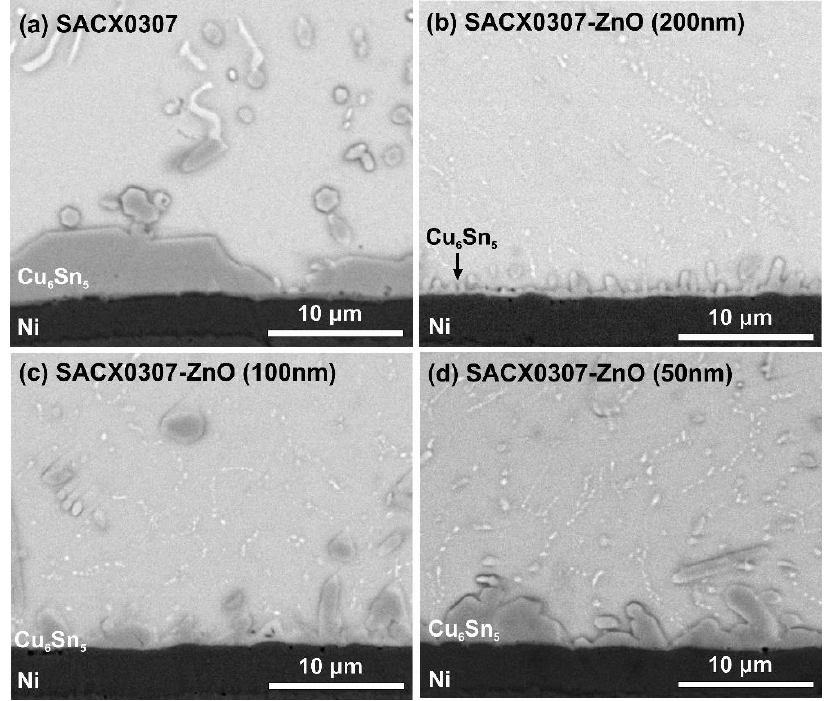
Figure 10. SEM-SE micrographs of lower IMC layer structures: ( a ) SACX0307; ( b ) SACX0307-ZnO- (200 nm); ( c ) SACX0307-ZnO-(100 nm); ( d ) SACX0307-ZnO-(50 nm).